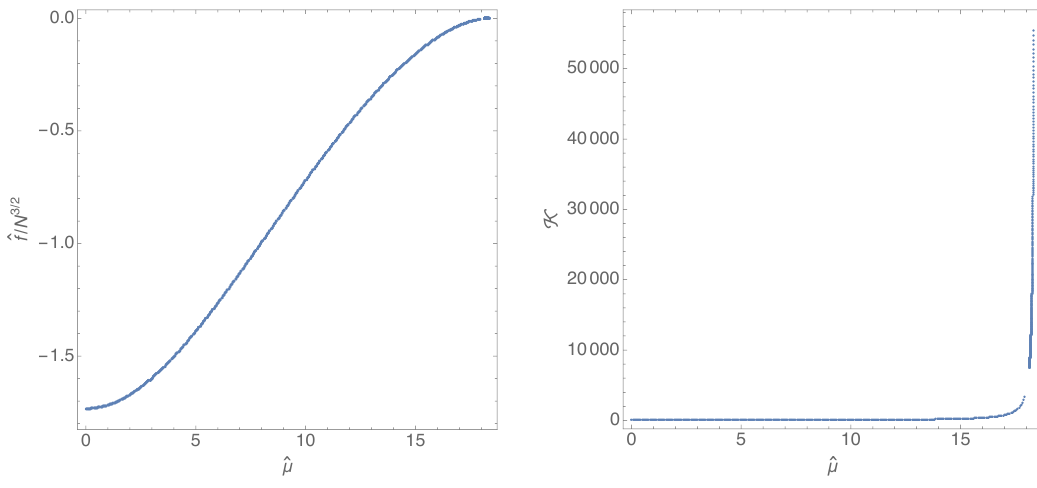
Figure 1 . Left panel : the dimensionless free energy density ^ f as a function of ^ (cid:22) : ^ f reaches zero at ^ (cid:22) c (cid:25) 18 : 3906 (cid:6) 0 : 0046 with what appears to be zero derivative. Right panel : the Kretschmann scalar K as a function of ^ (cid:22) .